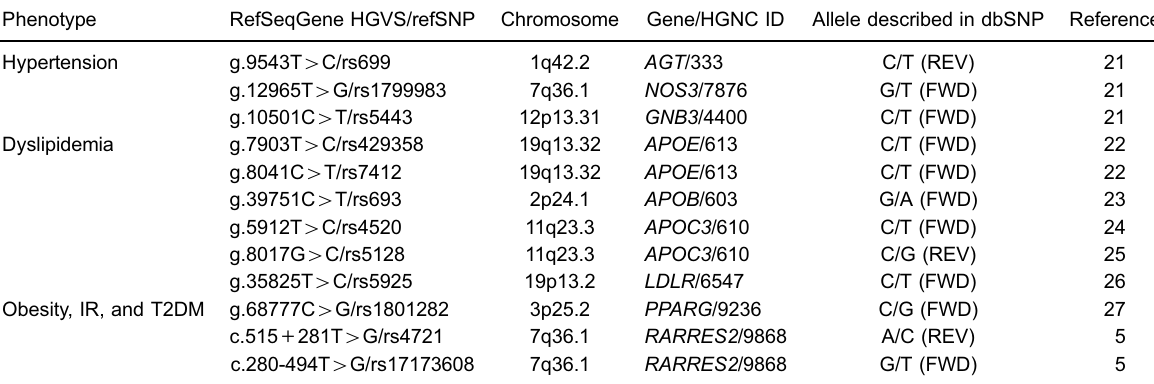
Table 1. Panel characteristics of 12 single nucleotide polymorphisms (SNPs) selected for the